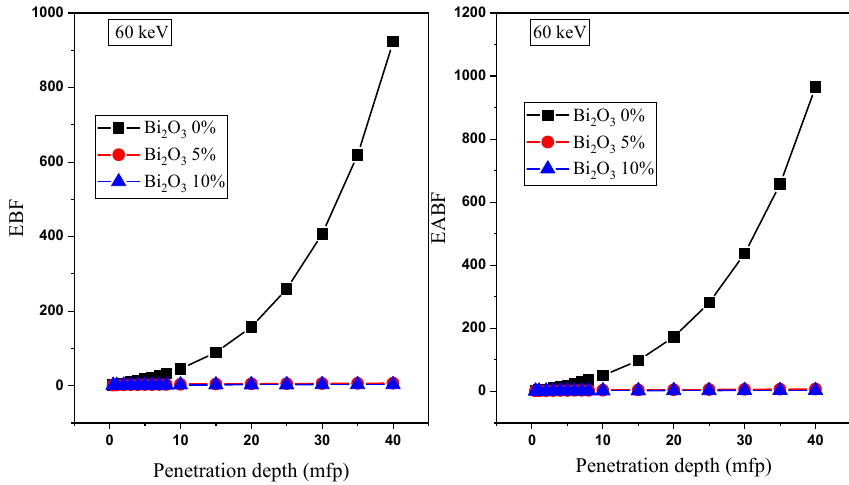
Figure 12. Variation in EBF and EABF values versus the penetration depth.